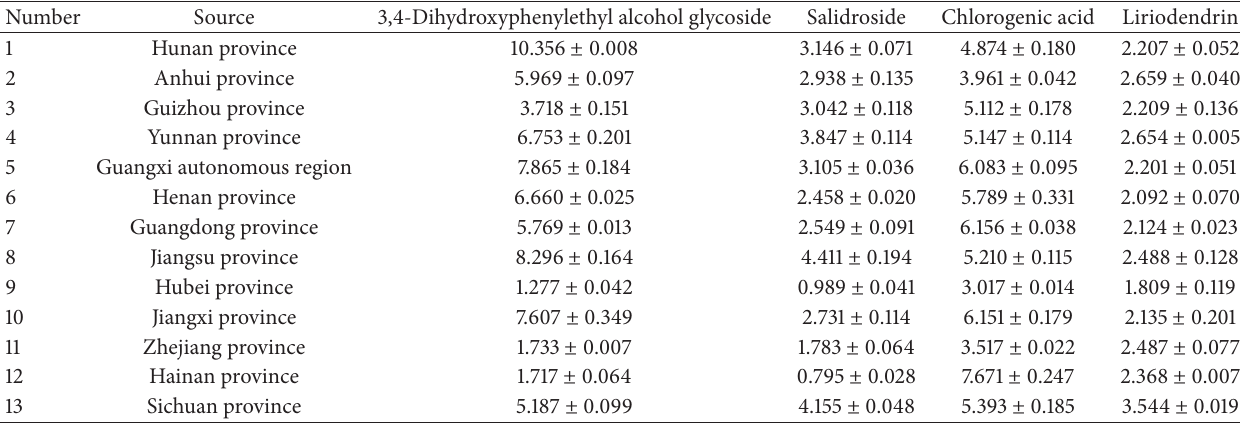
Table 3: The contents of the four analytes in the stem of S. cuneata ( 𝑛 = 3 , mean ± SD,